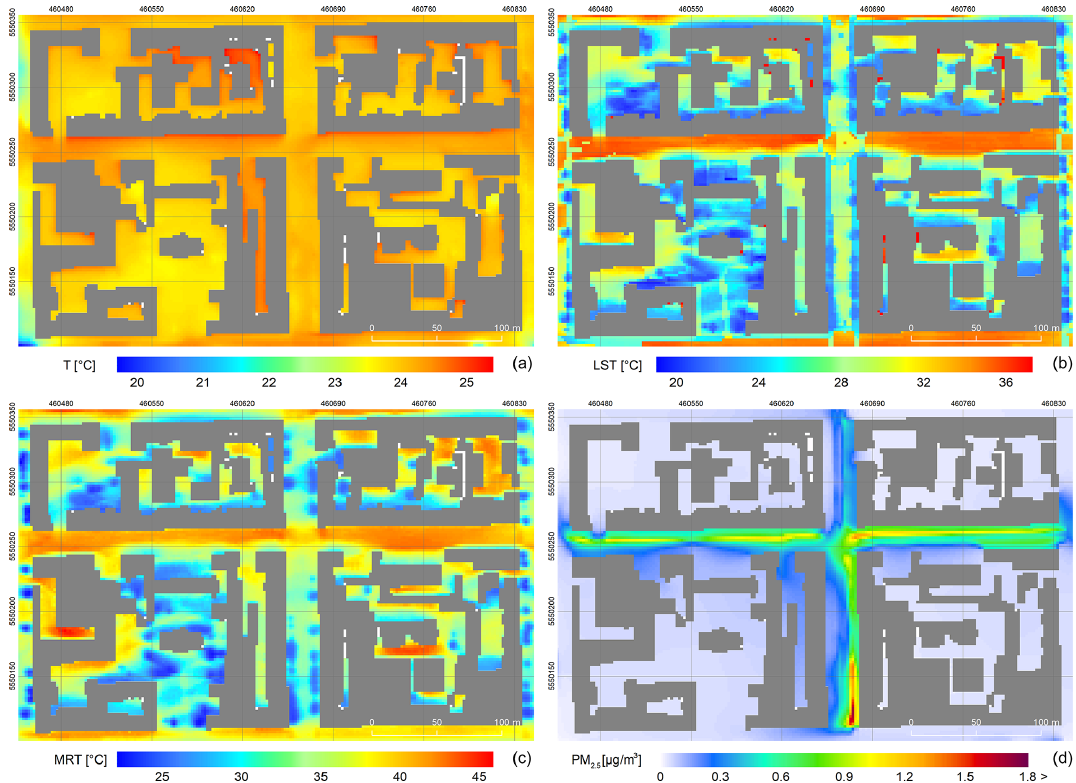
Figure 2. Daily average spatial variability in (a) air temperature, (b) surface temperature, (c) mean radiant temperature – MRT – and (d) PM 2 . 5 concentrations for the baseline simulation. Projection: WGS 84 / UTM zone 33N; layer with roofs is own data